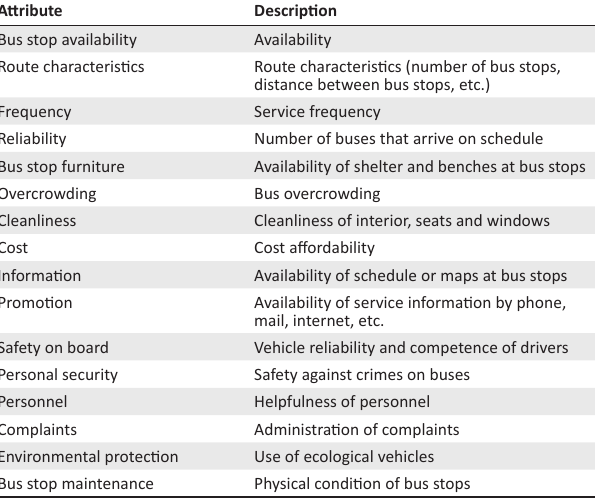
TABLE 1: Service quality